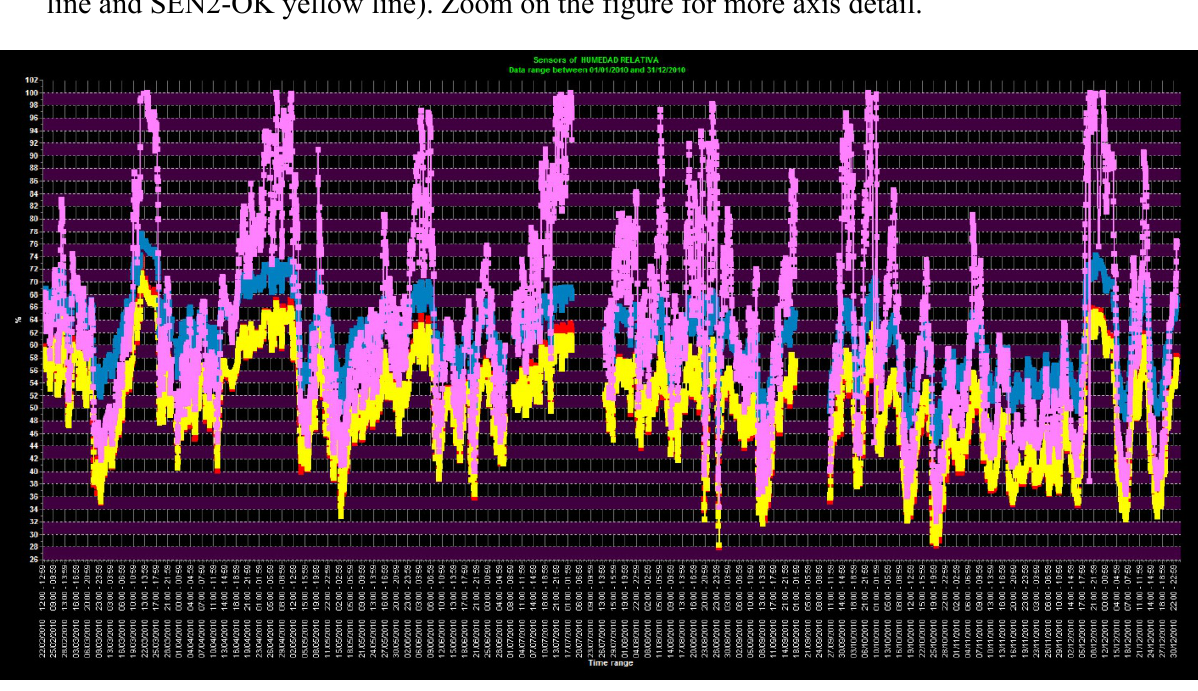
Figure 13. Annual time series of hourly averaged data (2010) of four RH sensors, two of them located in the area with salt efflorescence (SEN3-X blue line and SEN4-X violet line) and two sensors in the area where the frescoes do not show deterioration (SEN1-OK red line and SEN2-OK yellow line). Zoom on the figure for more axis